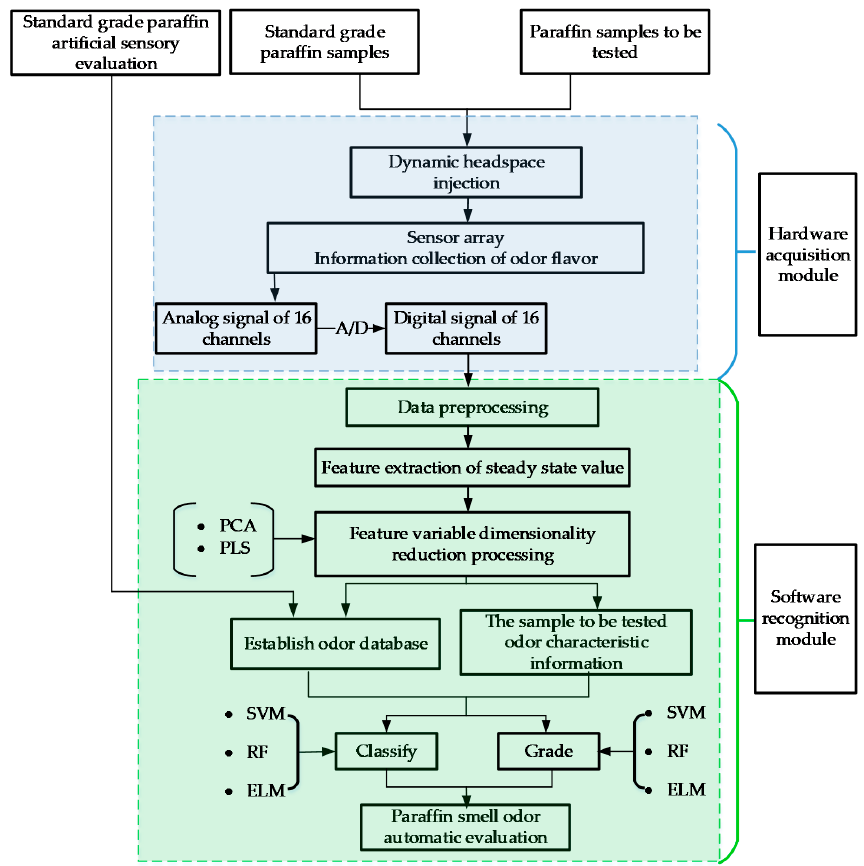
Figure 1. A schematic diagram of the paraffin odor analysis system.